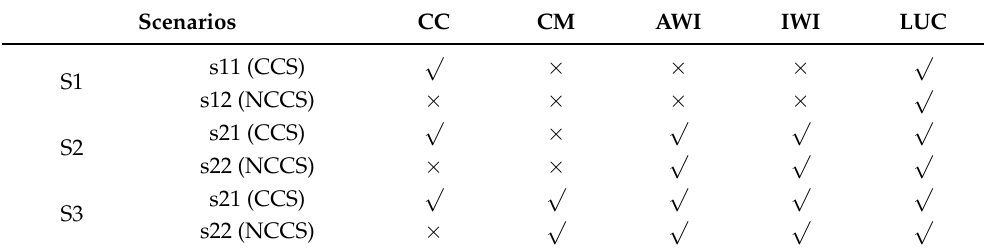
Table 2. Scenario settings and considered factors.